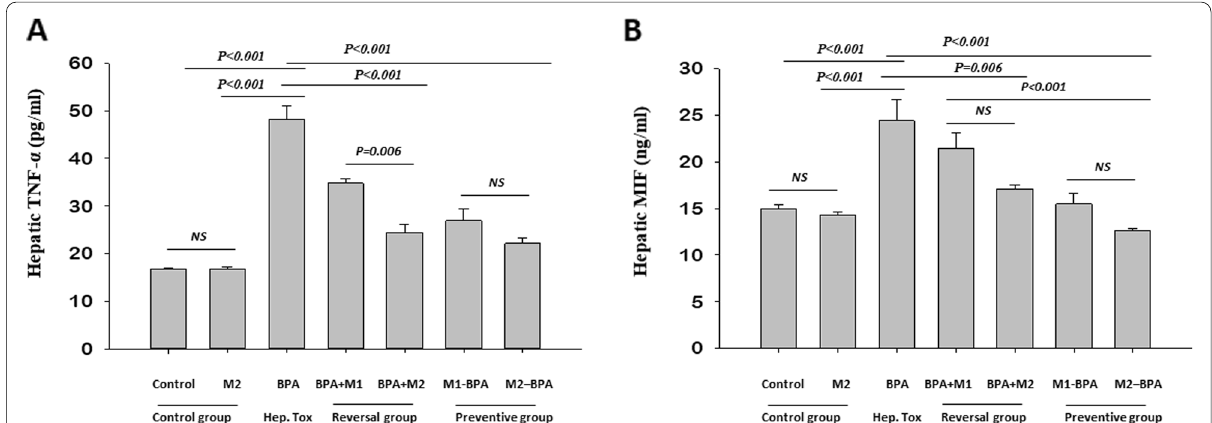
Fig. 4 Effect of Moringa oleifera on the inflammatory activity of the liver tissue in BPA‑induced hepatotoxicity rats. Hepatic tumor necrosis factor (TNF‑α, A ) and macrophage migrating inhibitory factor (MIF, B ) levels were assessed in all groups. All data were presented as mean rats/group, BPA bisphenol‑A (50 mg/kg BW). M1 Moringa oleifera (200 mg/kg BW); M2 Moringa oleifera (400 mg/kg BW); P < 0.05 was considered significant. NS non‑significant, P >